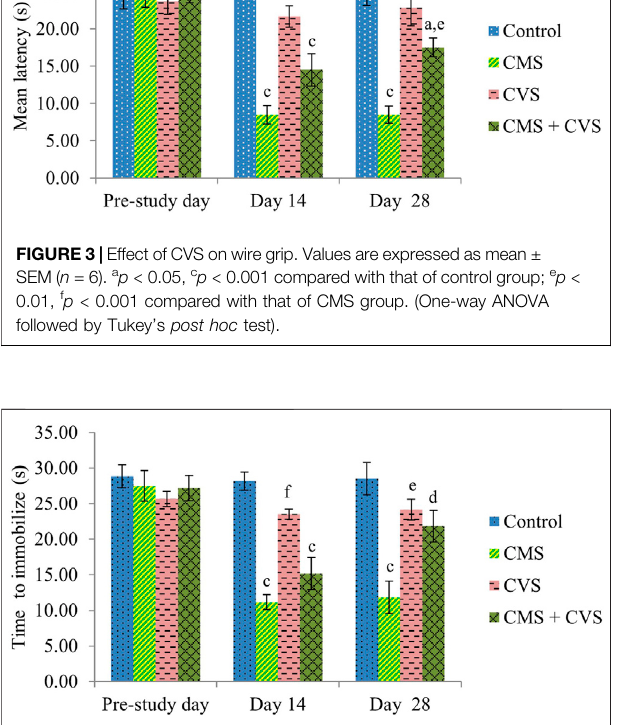
FIGURE 4 | Effect of CVS on immobilization time. Values are expressed as mean ± SEM (n = 6). c p < 0.001 compared with that of control group; d p < 0.05, e p < 0.01, f p < 0.001 compared with that of CMS group. (One-way ANOVA followed by Tukey ’ s post hoc